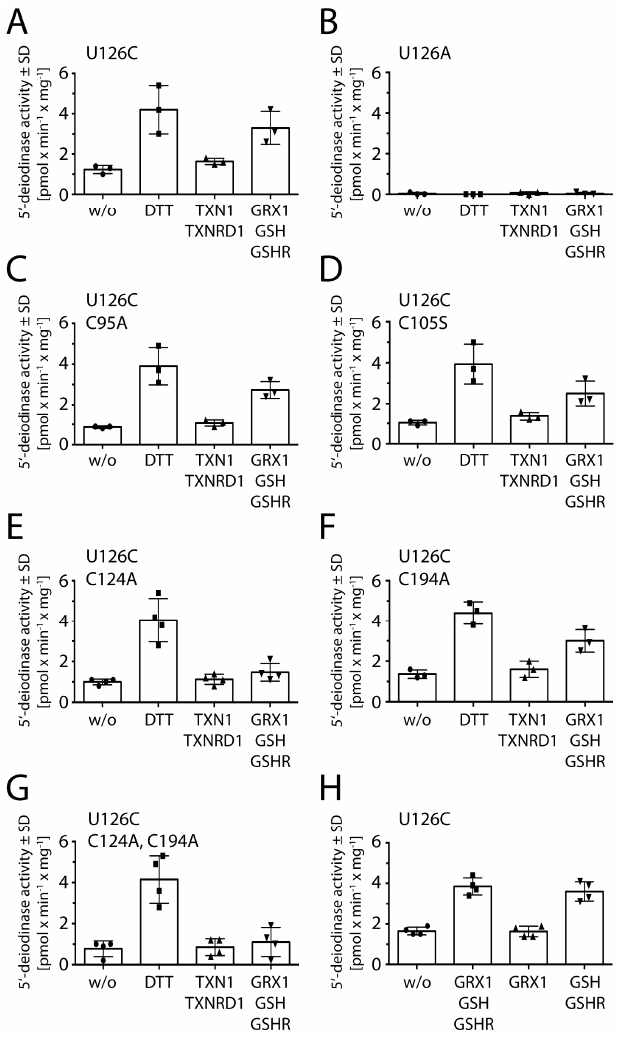
Figure 3. 5 ′ -deiodinase activity of recombinant purified DIO1 U126C variants using different reducing systems. ( A ). DIO1 U126C , ( B ). DIO1 U126A served as a negative control, ( C ). DIO1 U126C/C95A , ( D ). DIO1 U126C/C105S , ( E ). DIO1 U126C/C124A , ( F ). DIO1 U126C/C194A , ( G ). DIO1 U126C/C124A/C194A . ( H ). DIO1 U126C is not active with GRX alone, but requires GSH. w/o: without reductant, 20 mM DTT; 3 µM TXN1 and 0.1 µM TXNRD1; and 1 mM GSH, 1 µM GRX1, and 0.05 µM GSHR; and 200 µM NADPH. The experi- ment was performed with protein from 3 to 4 different transductions of Hi5 cells. SD: standard deviation.